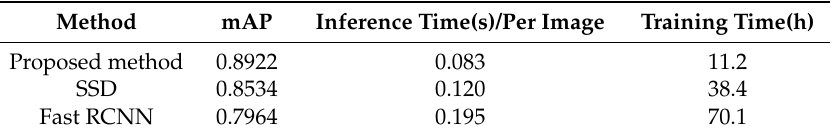
Table 2. Comparison with Other